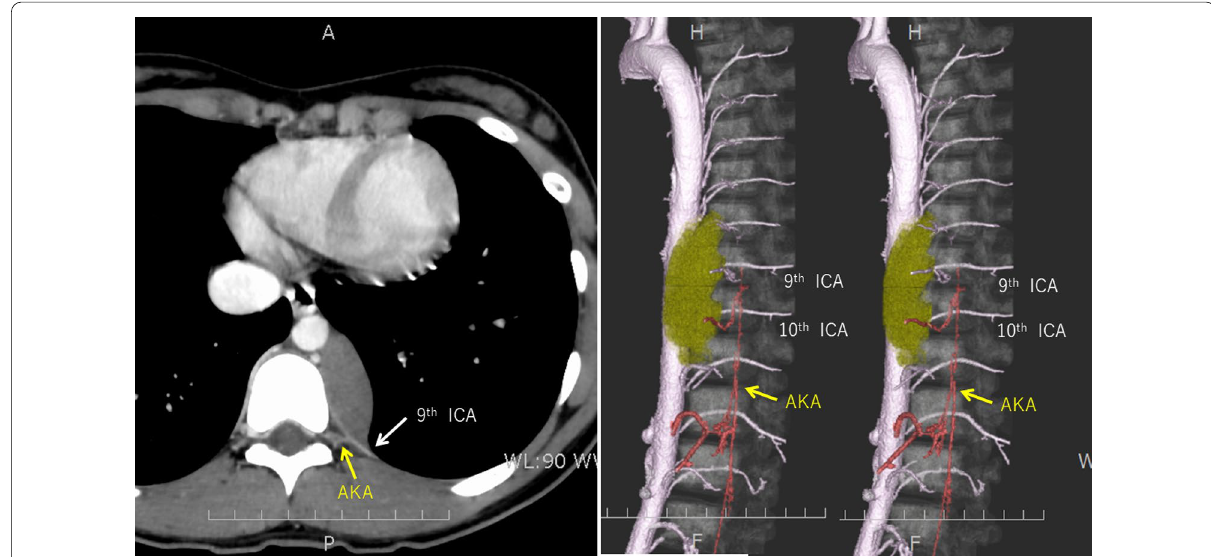
Fig. 2 Contrast-enhanced computed tomography (CT) showed that the artery of Adamkiewicz arose from the 9th intercostal artery that ran between the tumor and the vertebrae. AKA, artery of Adamkiewicz; ICA, intercostal artery